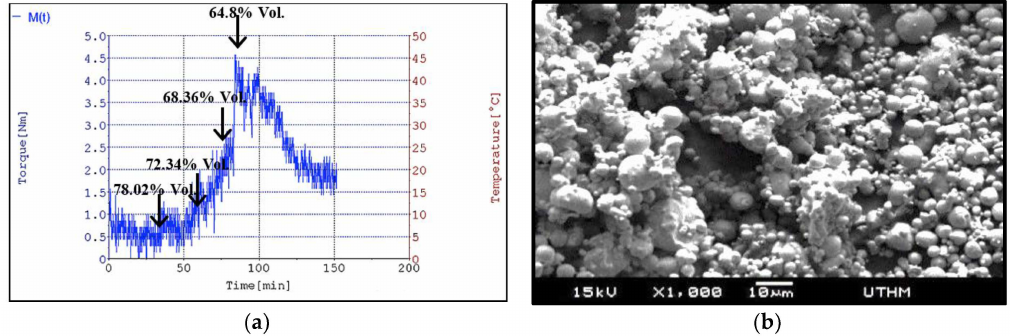
Figure 1. ( a ) CPVC of water atomized SS316L powder [30]; ( b ) Powder morphology.